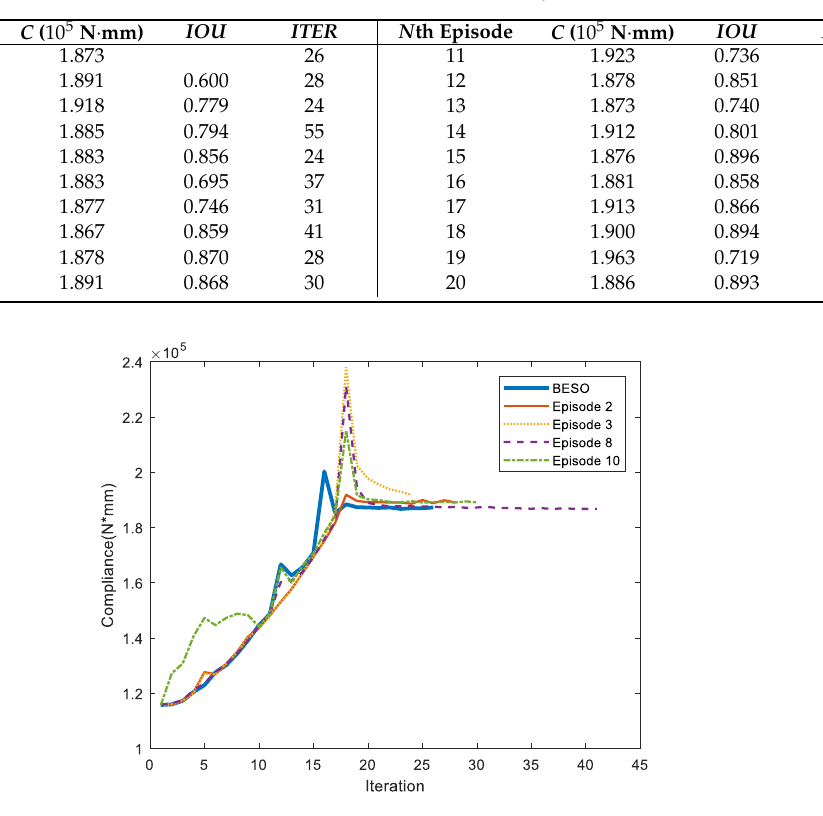
Figure 7. Evolutionary histories of the compliance for the cantilever beam by UCB with BESO.